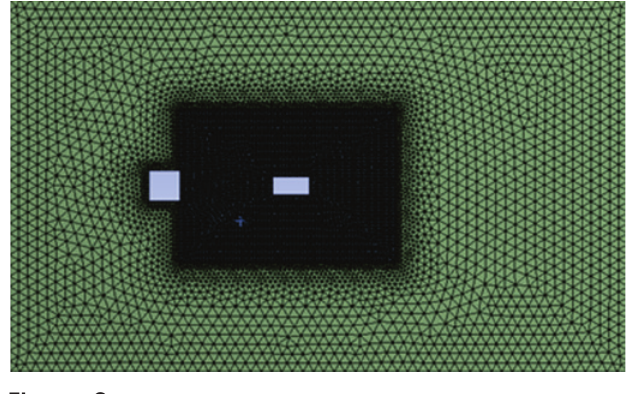
Figura 9 Malha de volumes finitos para o problema acoplado